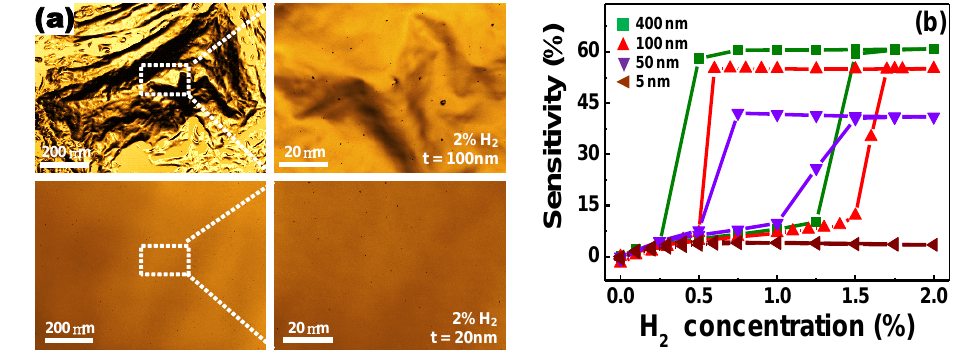
Figure 3. (a) Confocal laser scanning microscopy images of the Pd thin films with the thicknesses of 100 and 20 nm, respectively, after exposure to 2% H concentration curves for Pd films with different thicknesses of 5 to 400 nm undergoing cyclic H absorption and desorption processes. Data reproduced from Lee et al . 2